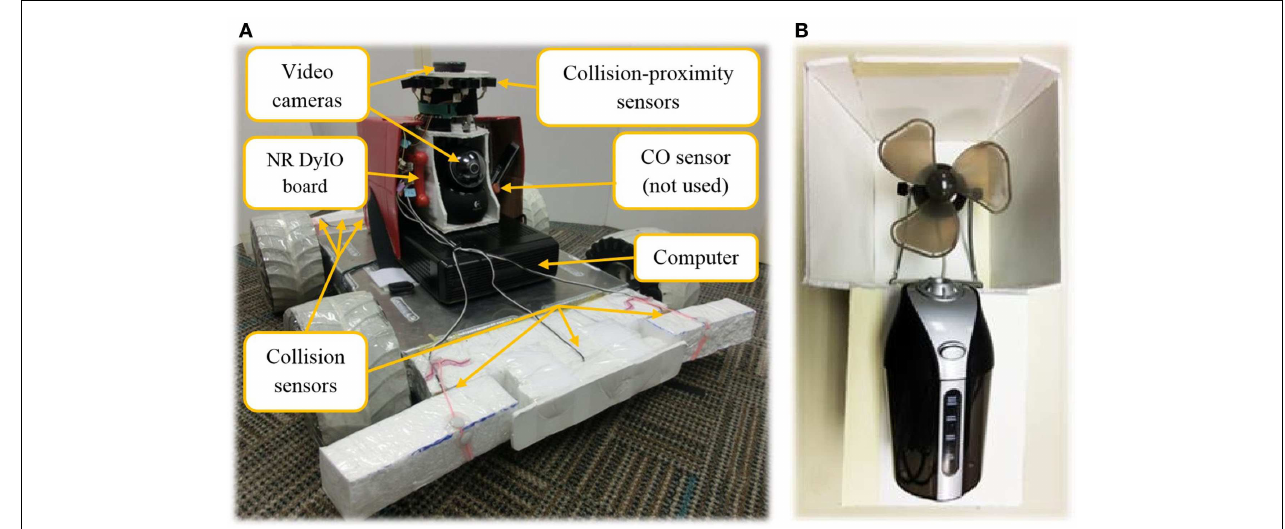
FIGURE 7 | Hardware for study #4: (A) robotic rover and its subparts, and (B) smell diffusion device .